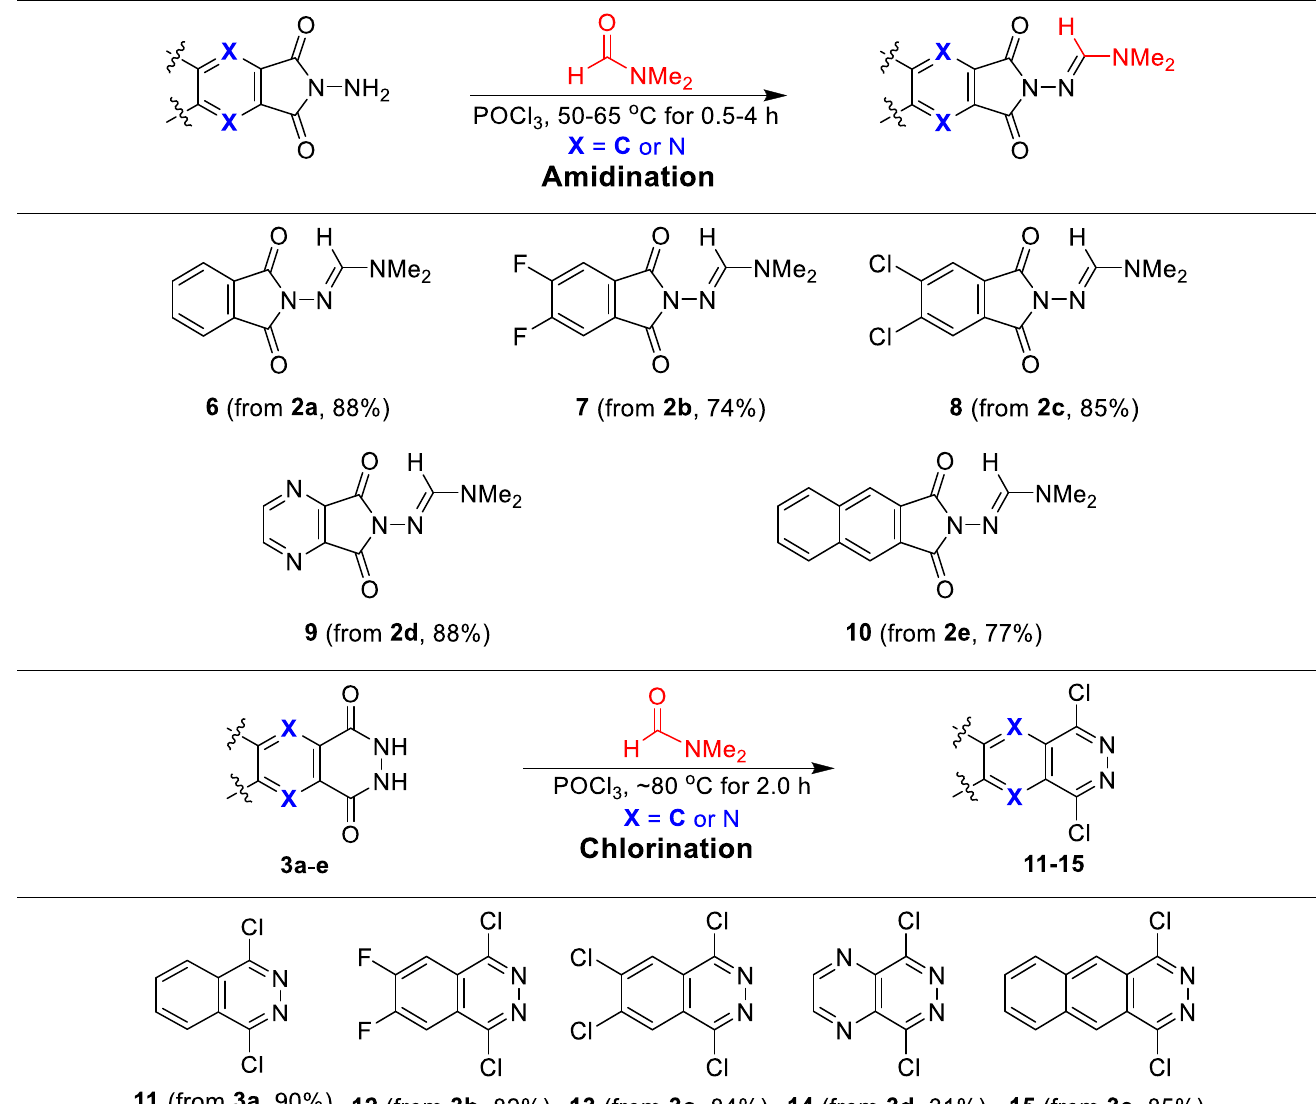
Table 2. Derivatization results of N -aminophthalimides 2a – e and phthalazine 1,4-diones 3a – e with Vilsmeier reagent.